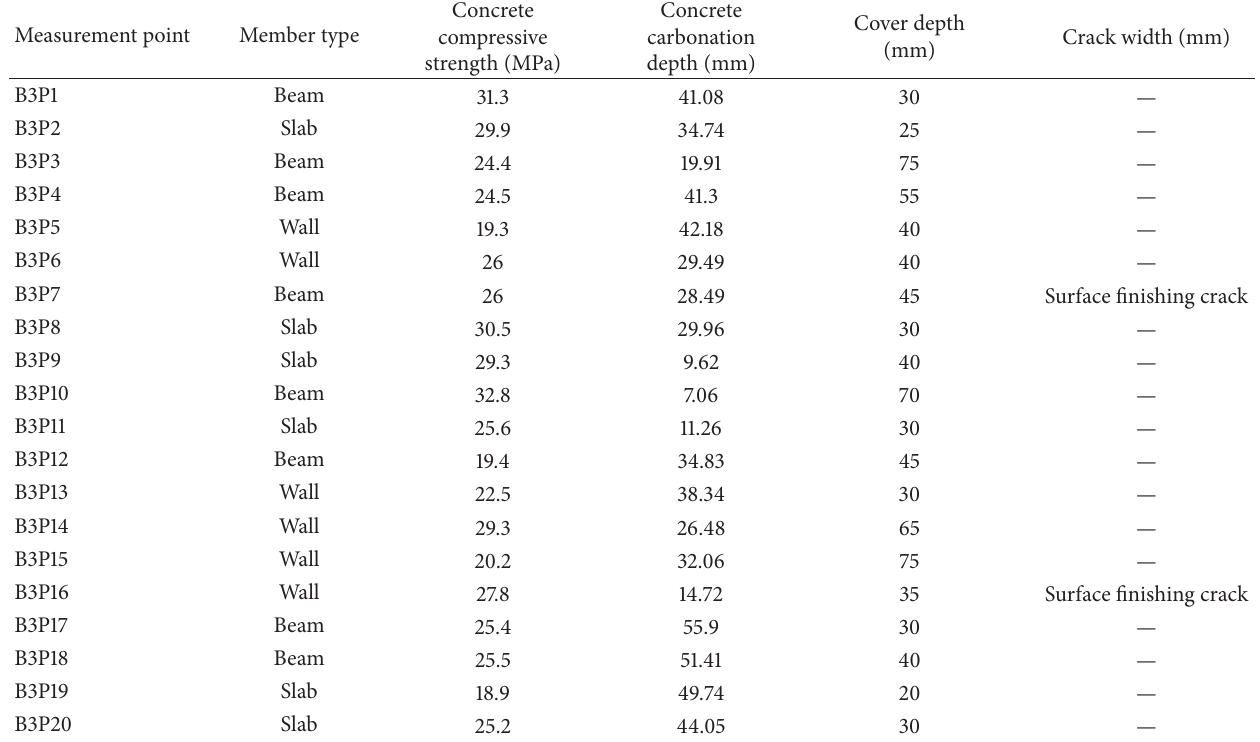
Table 5: Field investigation data (Building 3, construction completion year: 1981).